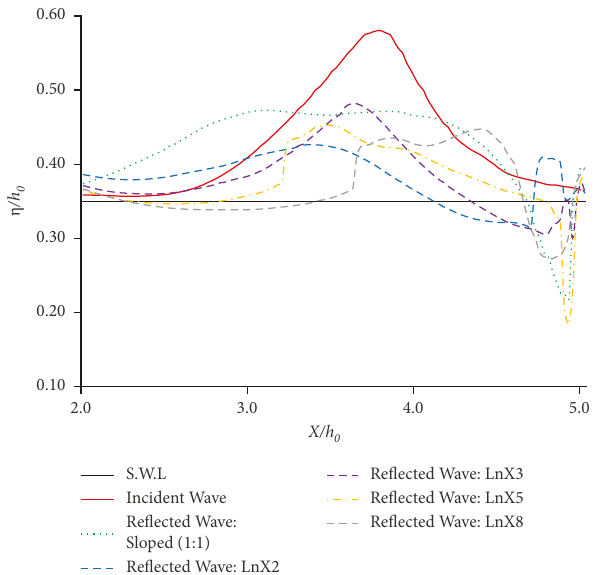
Figure 19: Comparison of normalized wave run-up versus nor- malized wave height for parabolic and sloped ones.